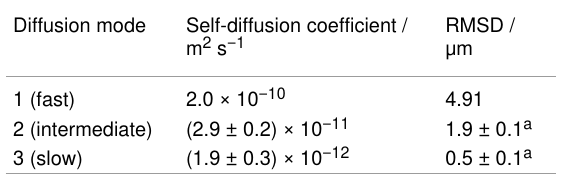
limit. While for the microporous titanosilicate it was expected that the too small pores prohibit accommodation of triolein mol- ecules. For P-ETS-10/60 this might result from the decreased surface hydrophobicity (as seen by the 29 Si NMR and indi- rectly by the NH 3 -TPD), preventing efficient diffusion into the mesopores of the crystals. The discussed scenarios are illus- trated in Figure 17 with representation of the respective diffu- sion modes. To the best of our knowledge, this study represents the first direct measurement of the self-diffusion coefficient of (any) triglyceride or oil (as their mixture) confined to nanopores of (any) catalyst. Table 4: Result of the fitting of the data presented in Figure 16: the self-diffusion coefficients and the resulting root mean squared dis- placements